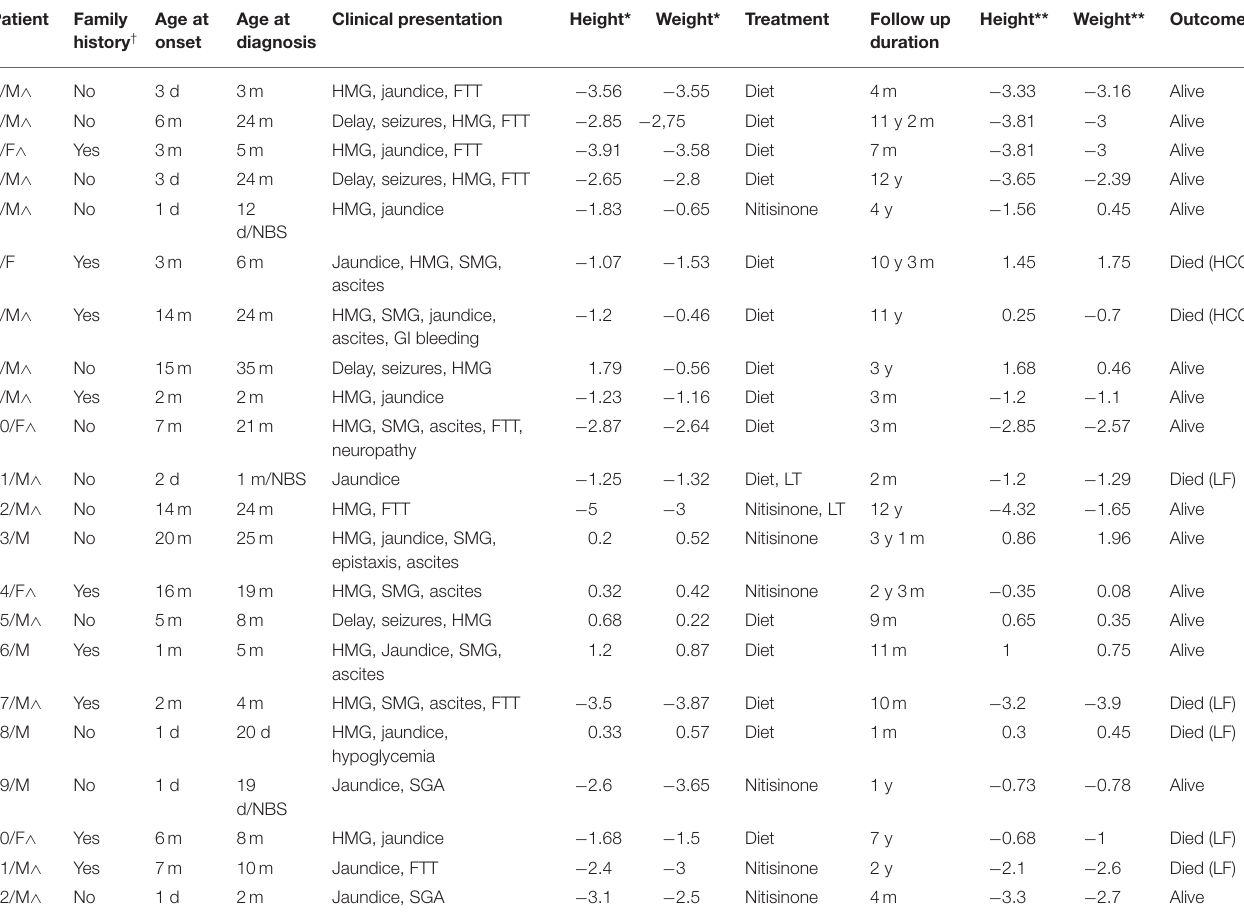
TABLE 1 | Clinical presentation, treatment, and outcome of Hereditary Tyrosinemia type 1 patients in Lebanon. Patient Family Age at history †